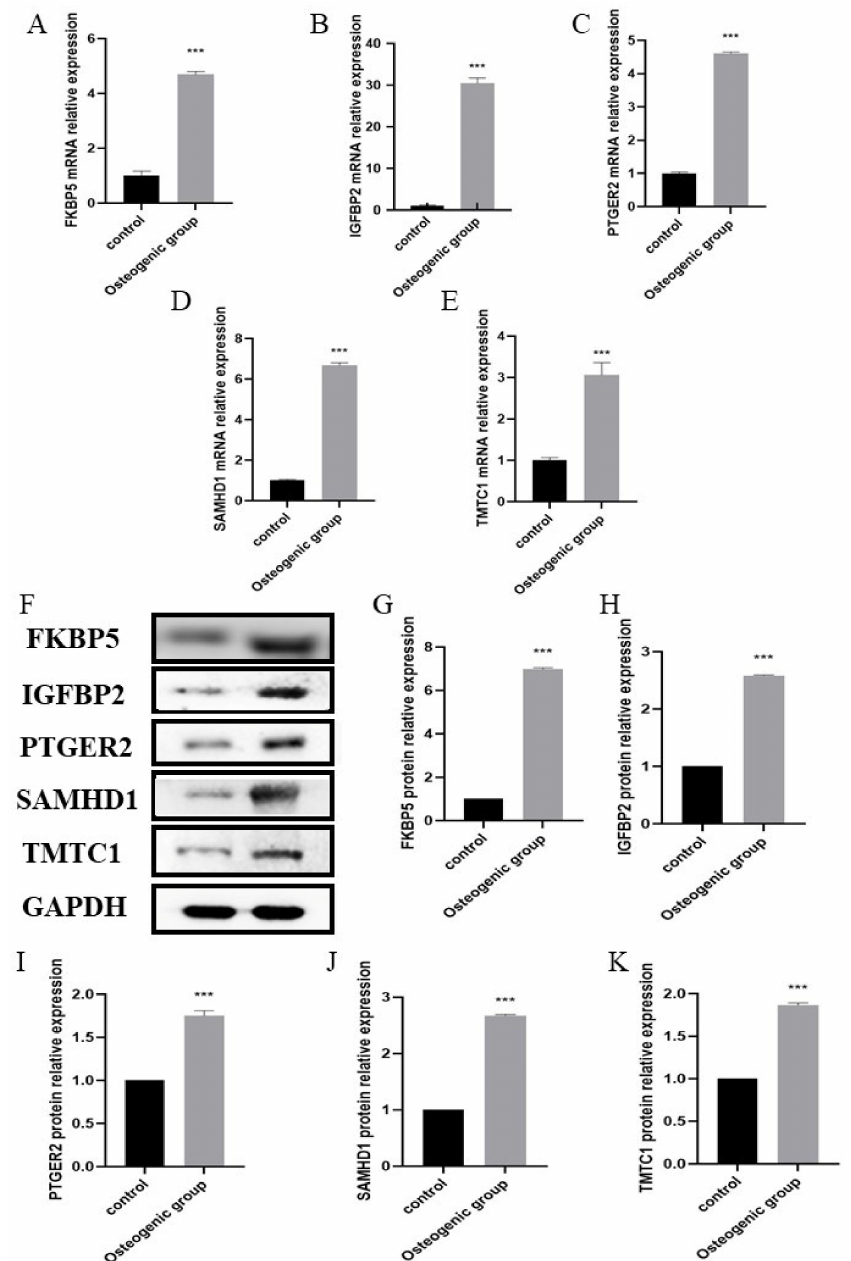
Figure 13. ( A − E ) The expression of FKBP5 ( A ), IGFBP2 ( B ), PTGER2 ( C ), SAMHD1 ( D ) and TMTC1 ( E ) quantified by qPCR in the uninduced and the osteogenic induced of ADSCs. ( F ) The expression of the biomarkers analyzed by Western blot. ( G − K ) Relative intensity analyses of Western blot results of FKBP5 ( G ), IGFBP2 ( H ), PTGER2 ( I ), SAMHD1 ( J ) and TMTC1 ( K ). p < 0.001